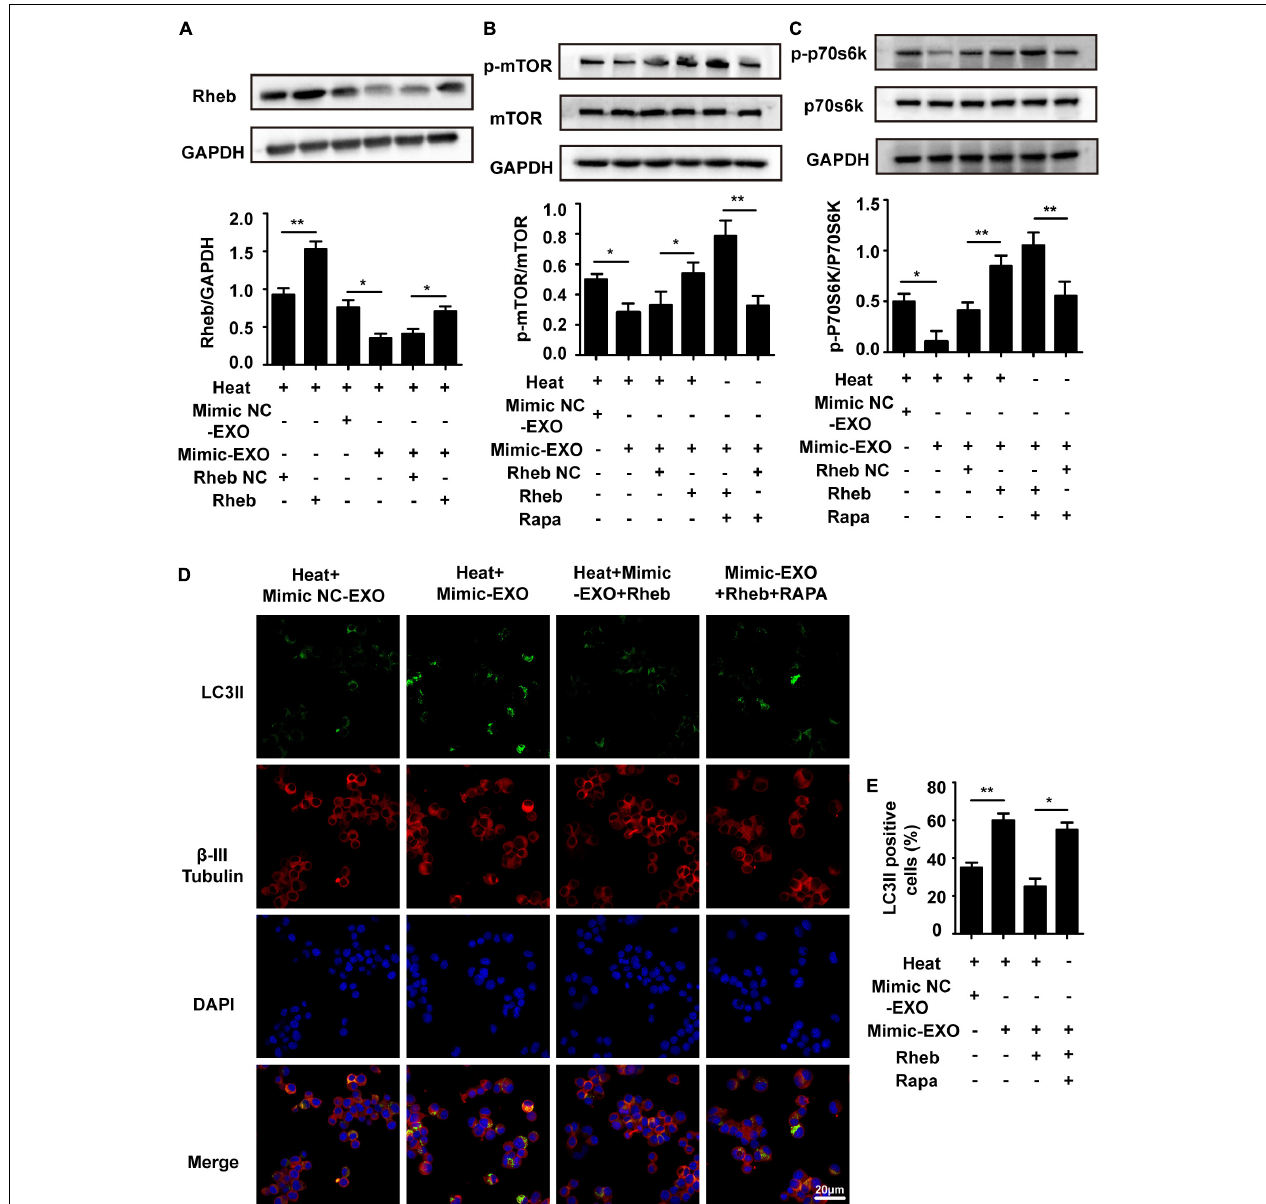
FIGURE 7 | Overexpression of Rheb ameliorates microglial exosomal miR-155-induced neuronal autophagy by promoting mTOR signaling. N2a cells were transfected with or without a recombinant lentivirus that overexpressed Rheb and then incubated with miR-155-upregulated microglial exosomes (50 µ g/ml) alone or together with 100 nM Rapa. Afterward, the cells were subjected to sham or heat stress at 42 ◦ C for 2 h, followed by a 6 h recovery period at 37 ◦ C. (A–C) The expression of Rheb and activation of mTOR and p70s6k with antibodies against Rheb, phospho-mTOR, phospho-p70s6k, mTOR, and p70s6k was determined by Western blotting. Densitometric analysis was performed. (D,E) The immunolocalization of LC3II and β -III Tubulin in the cytoplasm of N2a cells was examined via confocal microscopy. Representative images and the analysis are shown. Rapa is rapamycin, it could activate autophagy by specifically suppressing mTOR signal pathway in cells. All the data are presented as the means ± SDs of at least three independent experiments. * p < 0.05; ** p <